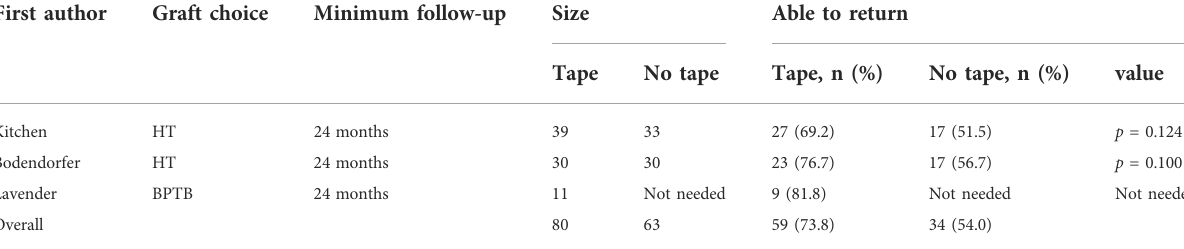
TABLE 7 Return to preinjury sports level between anterior cruciate ligament reconstruction with or without suture tape